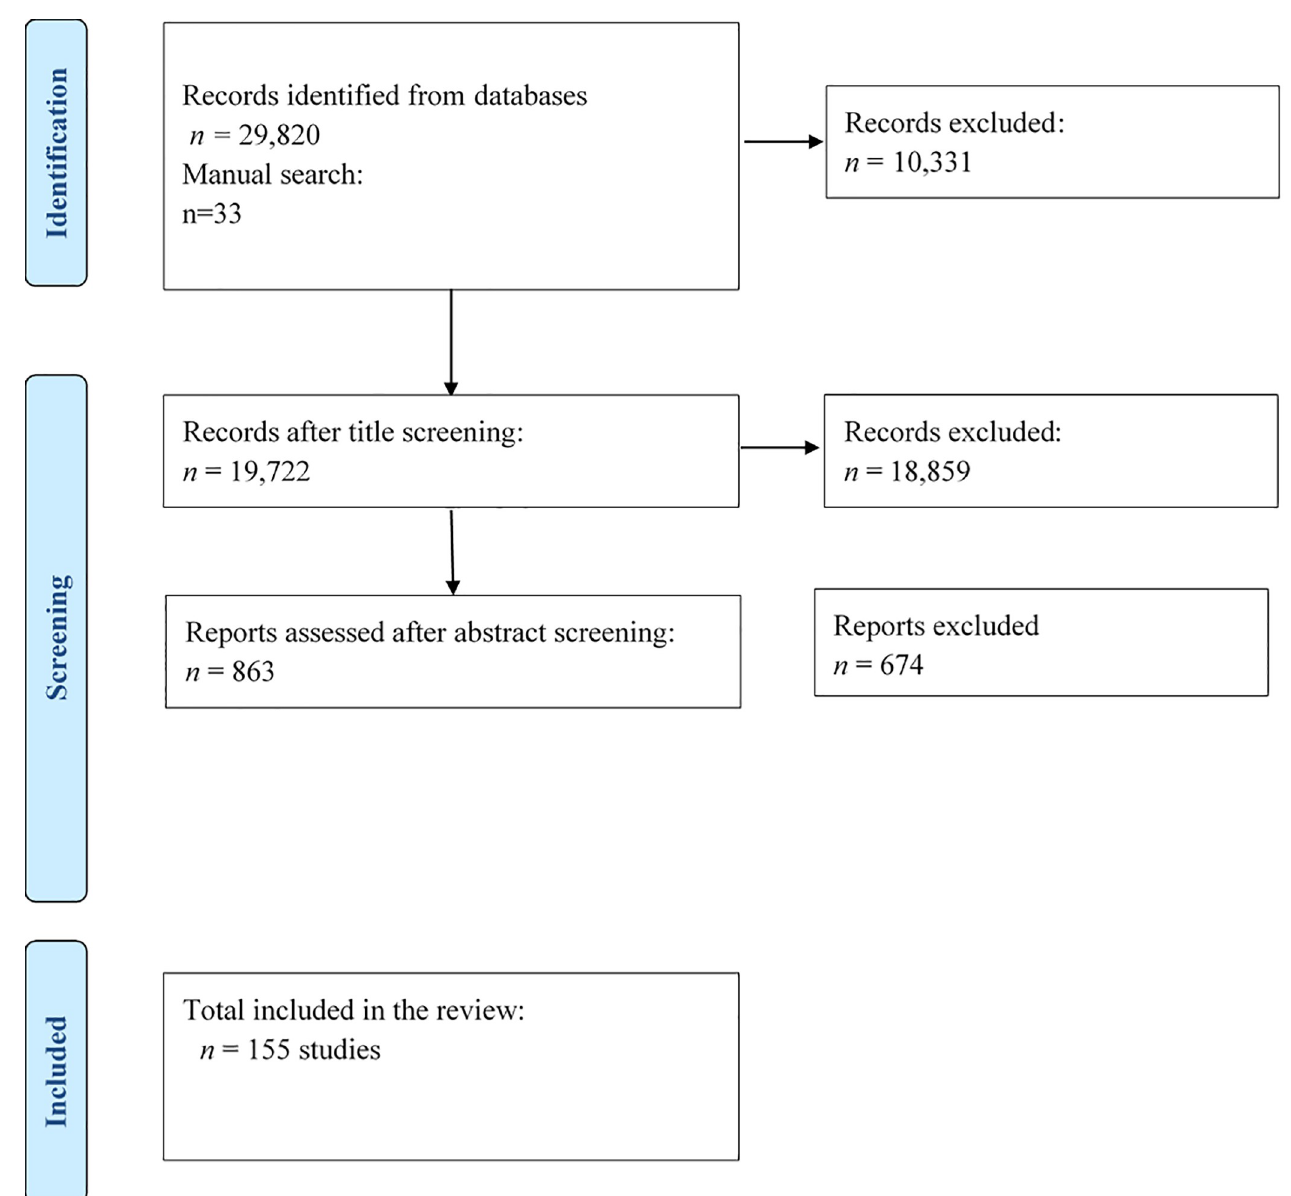
Fig 1. Prisma flow diagram of study selection.